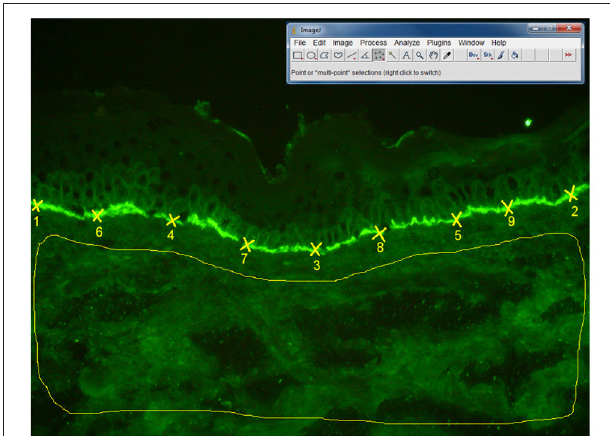
FIGURE 7 | Algorithm of measurement of fluorescence intensity in direct IF microscopy images, in patients with BP ( n = 27 patients). The fluorescence intensity was assessed by two independent blinded observers using Image J software, 1.47v version. The fluorescence intensity at the basement membrane was analyzed by selecting 50 points (using Multi-point tool), each point being situated at the half distance between two previous points. Background fluorescence was evaluated by selecting the whole dermis area, using “Freehand selections” tool. In order to obtain the mean value and standard deviation of the fluorescence intensity for the 50 points on the basement membrane and dermis background we have used the Analyze-Measure-Summarize